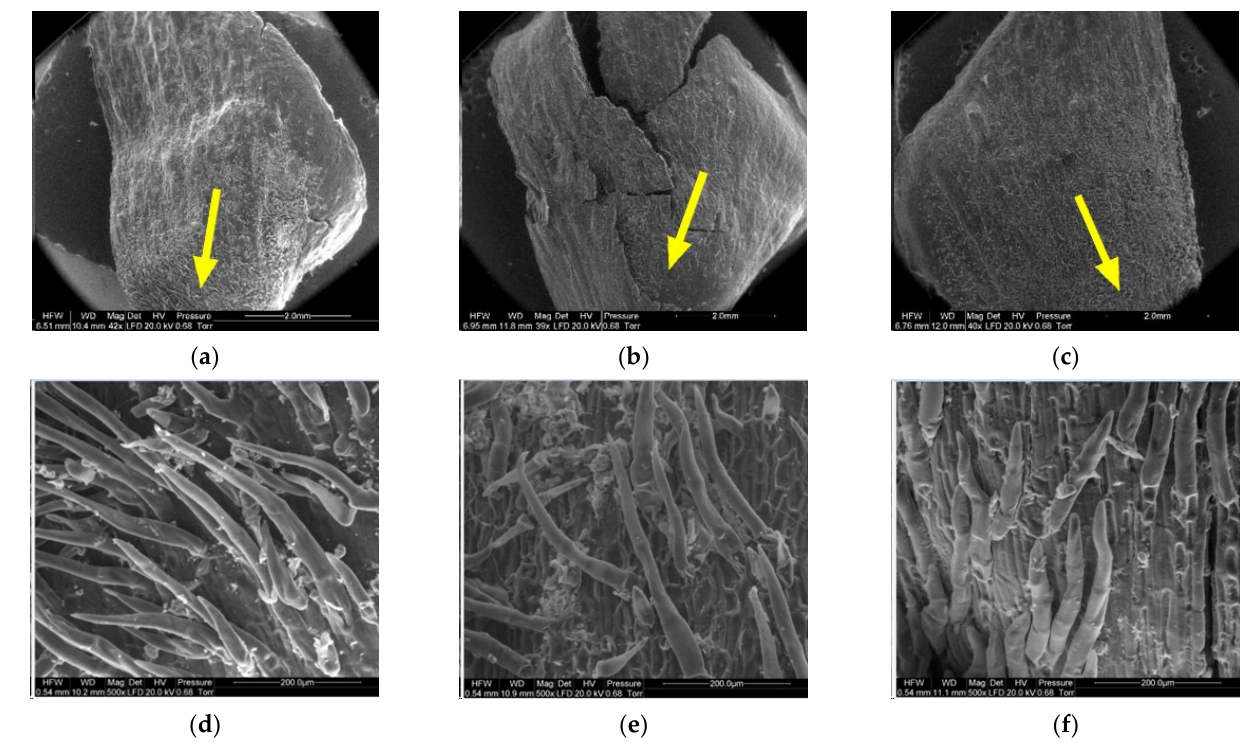
( e ) ( f ) Figure 13. Outer side of larch scale. Proximal scale area: ( a ) MC = 20%, zoom 50×; ( b ) MC = 10%, zoom 50×; ( c ) MC = 5%, zoom 50×; ( d ) MC = 20%, zoom 500×; ( e ) MC = 10%, zoom 500×; and ( f ) MC = 5%, zoom 500×. On the scale margin, outside of the wing area (1) there are elongated cells differing in their wall thickness. Table 3 shows means with standard deviations as well as minimum and maximum values for the studied cells. Table 3. Cell sizes at the scale margin outside of the wing area (1) on the inner side of scales with a moisture content of 5%, 10%, and 20%. Moisture Content of Scales Data